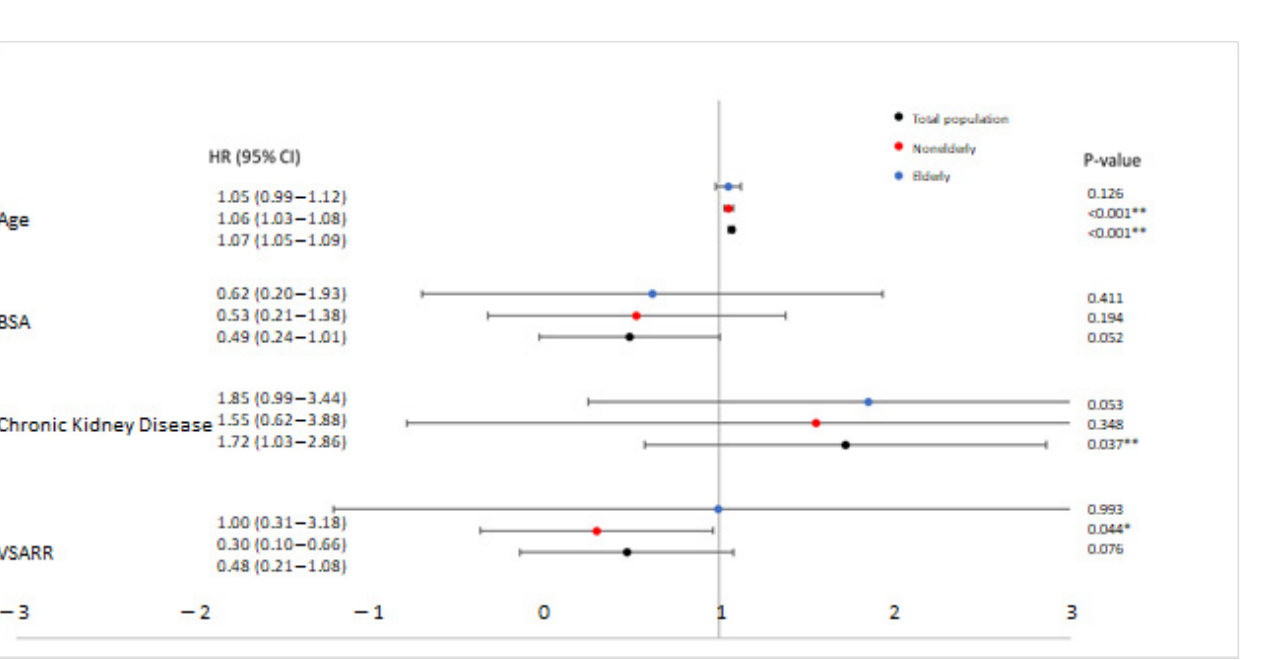
Figure 3. Forrest Plot of the Multivariable Analysis. Data are presented as Hazard Ratios (HR) with 95% Confidence Intervals (CI). VSARR: Valve Sparing Aortic Root Replacement (including partial Yacoub technique in this analysis); BSA: Body Surface Area . * Significant at the 0.05 level. ** Significant at the 0.01 level.